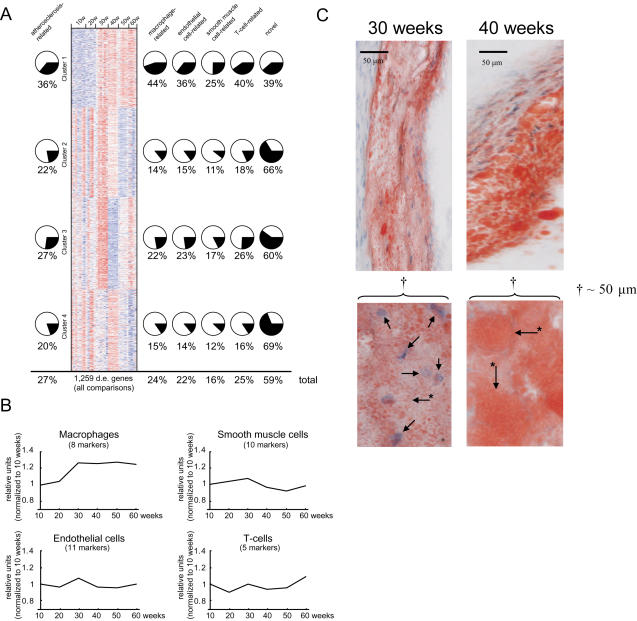
Transcriptional changes of atherosclerosis development.(A) Heat map of clustered mRNA levels (rows; red, high levels; blue, low levels) for genes differentially expressed (d.e.) in at least one pair-wise time-point comparison (FDR<0.05, n = 1259). Each column represents mRNA levels in one mouse (n = 5 to 7 per time point) at 10 to 60 weeks of age. Four gene clusters were identified by the cluster algorithm. Pie charts show percentages of genes related to atherosclerosis (Table S1) on the left and to the four atherosclerosis cell types (Tables S2, S3, S4, and S5) on the right. A substantial number of genes were related to more than one atherosclerosis cell type (Figure S1). The percentage of novel genes (i.e., not related to atherosclerosis or atherosclerosis cell types) in each cluster is shown on the far right. Overall percentages (total) are shown below. (B) Relative expression levels of cell-specific markers of atherosclerosis cell types (Table S7). The number of markers per cell type is indicated. The only statistically significant increase was in the number of foam cells, which increased by ∼30% between 20 and 30 weeks (P<0.001) and remained elevated at 60 weeks. (C) Representative sections of the aortic root (top) were stained with Oil-red-O (red in the figure) and counterstained with hematoxylin (Htx) (blue spots in the figure), bar in figure indicate 50 µm; higher-power views of 50 µm showing foam cells at 30 (arrows indicate macrophage Htx-stained nuclei, asterisk marked arrows point to the outer cell membrane) and 40 weeks (asterisk marked arrows point to the outer cell membrane of Oil-red-O-stained fat within macrophages, the nuclei are not visible) are shown below.